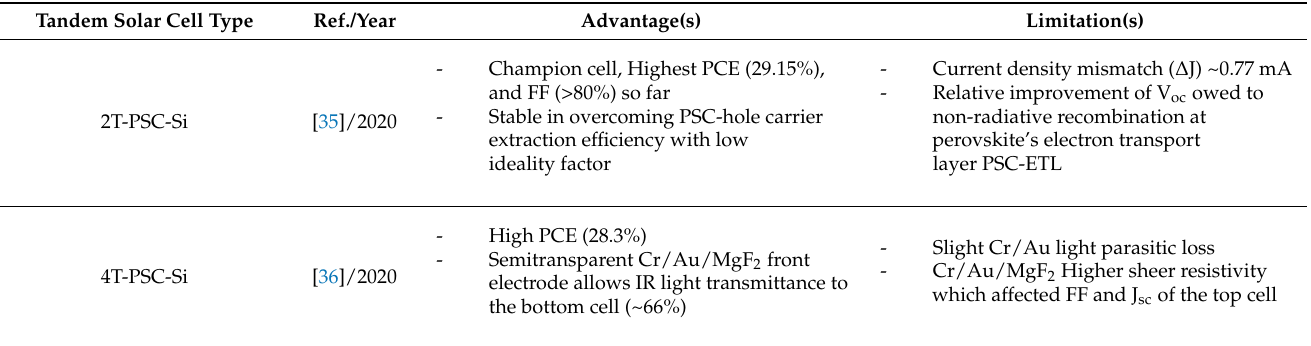
Table 2. Summary of the advantages and challenges based on PCS-Si tandem with various conditions, materials, and structure. Tandem Solar Cell Type